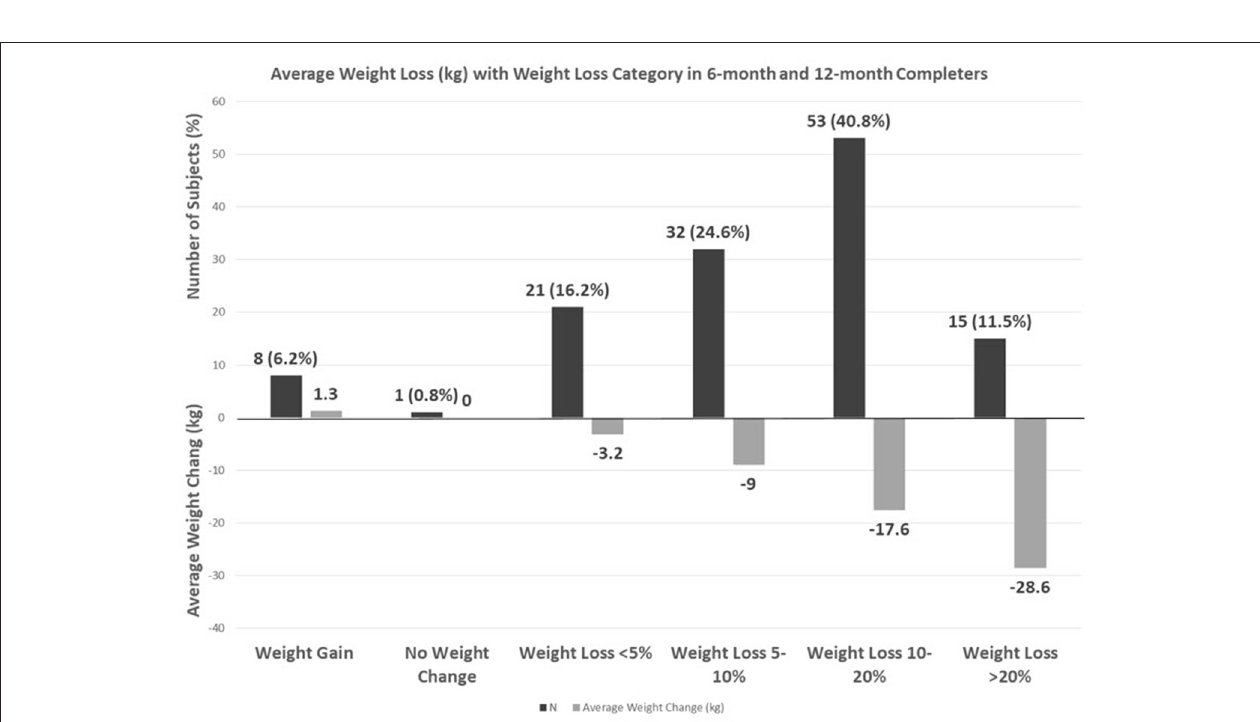
FIGURE 2 | Average weight loss (kg) with weight loss category in 6-month and 12-month completers.